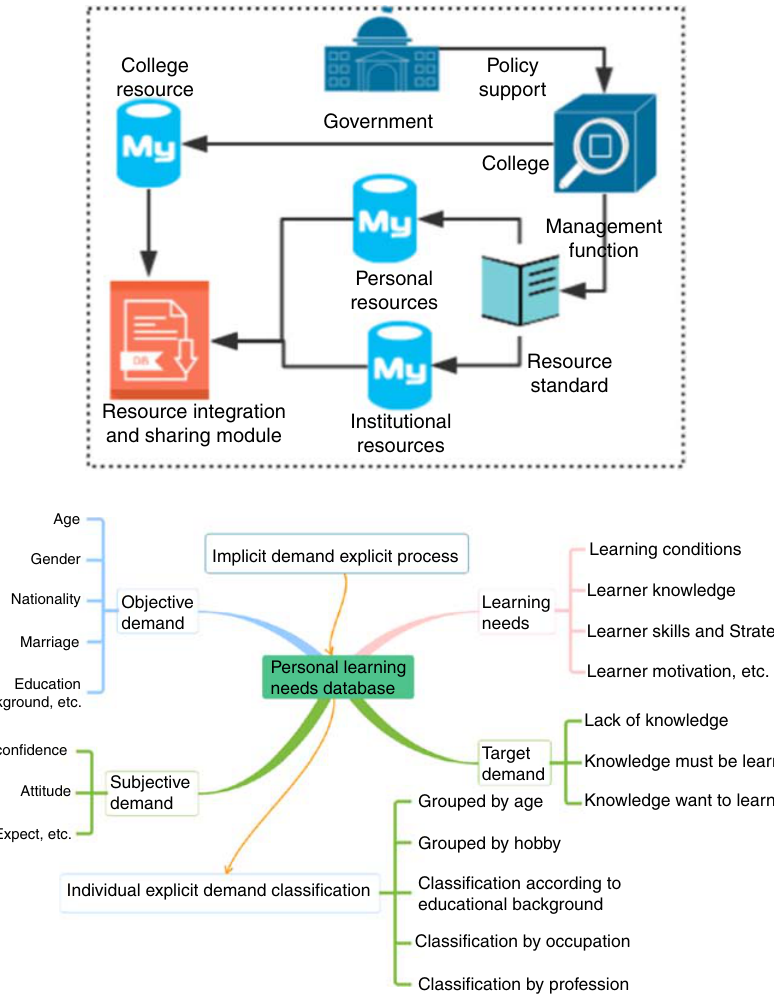
Figure 4. Requirements